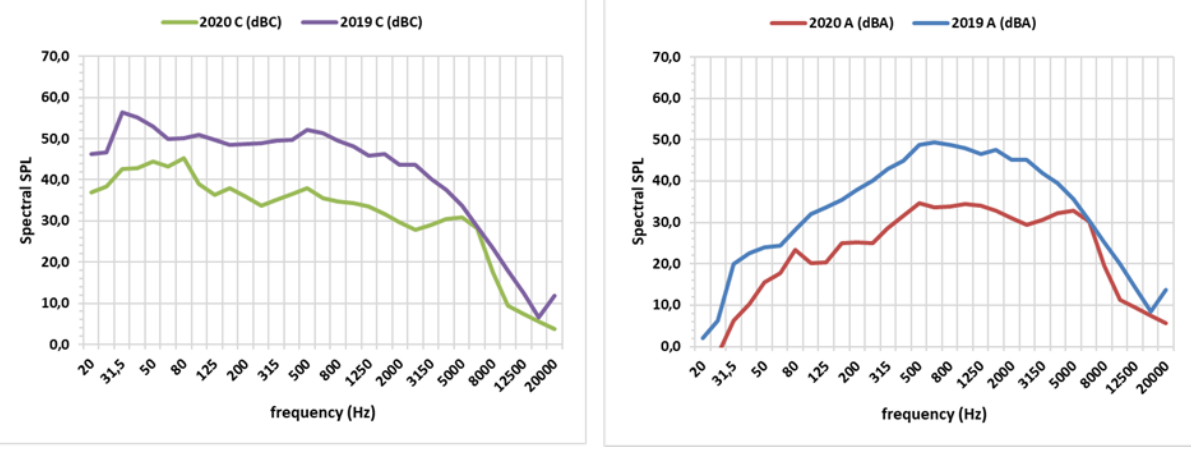
Figure 7: Overall C and A-weighted sound spectrum in 2019 vs 2020 at site no. 2 (PLT)